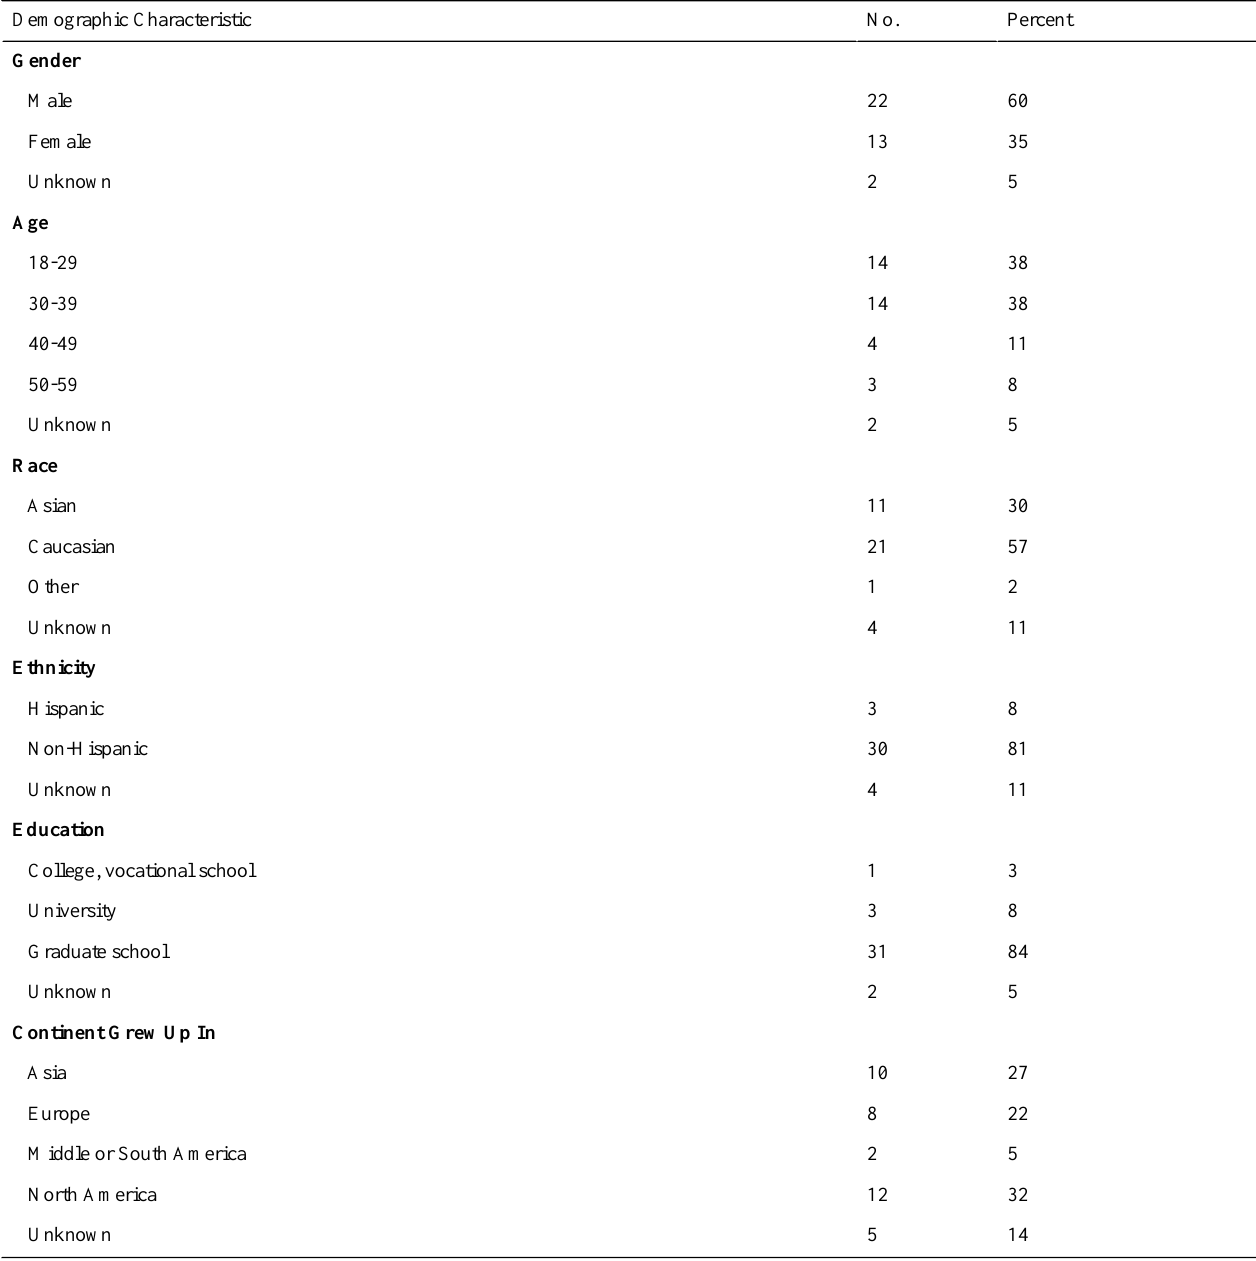
Table 2. Demographic characteristics of the survey participants PercentNo.Demographic